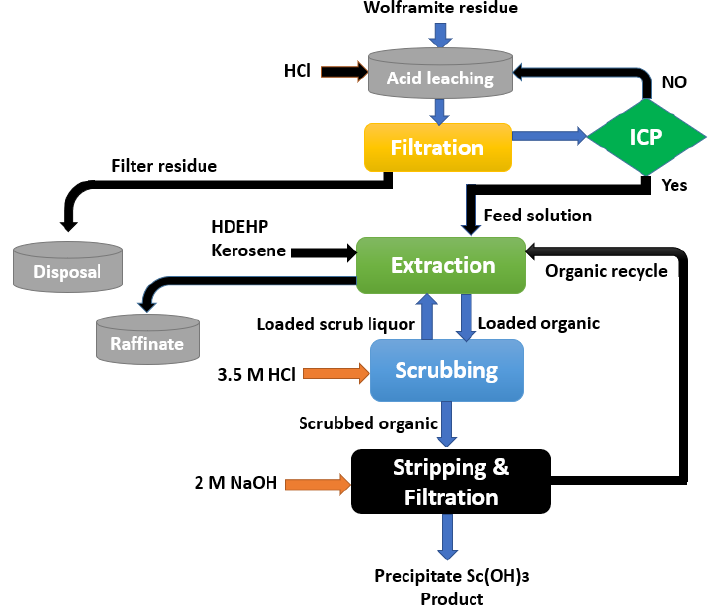
Figure 11. Scandium recovery from wolframite residue, adapted from [119].